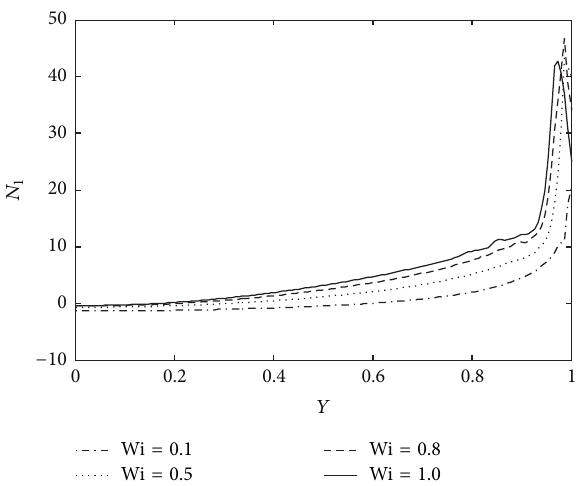
Figure 7: First normal stress difference at 𝑥 = −0.04 for various Wi with 𝛽 = 0.1